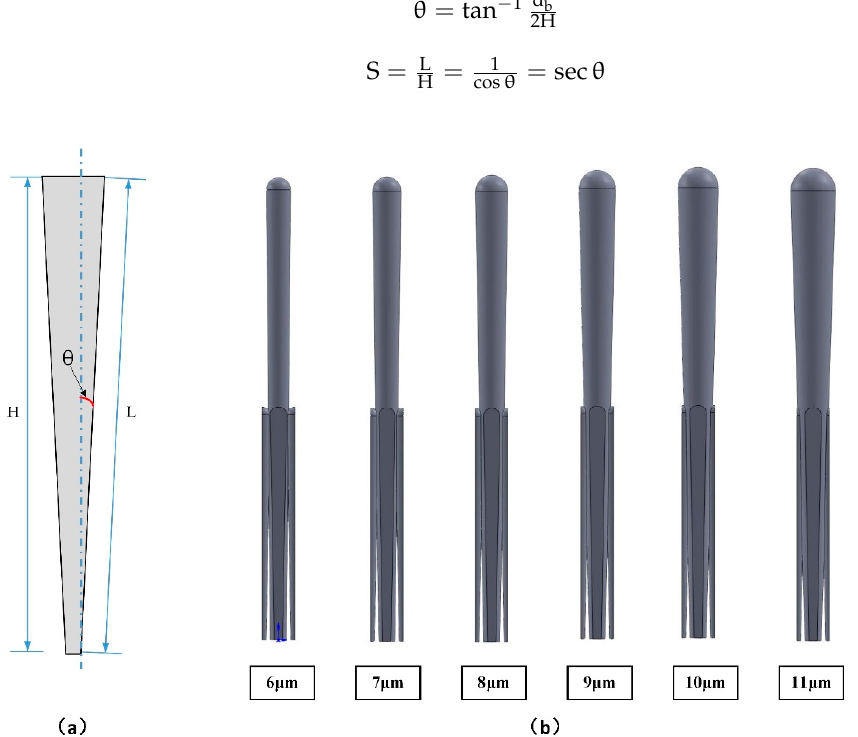
Figure 6. ( a ) The sectional view of coarse column and ( b ) coating models with different coarse column diameter.